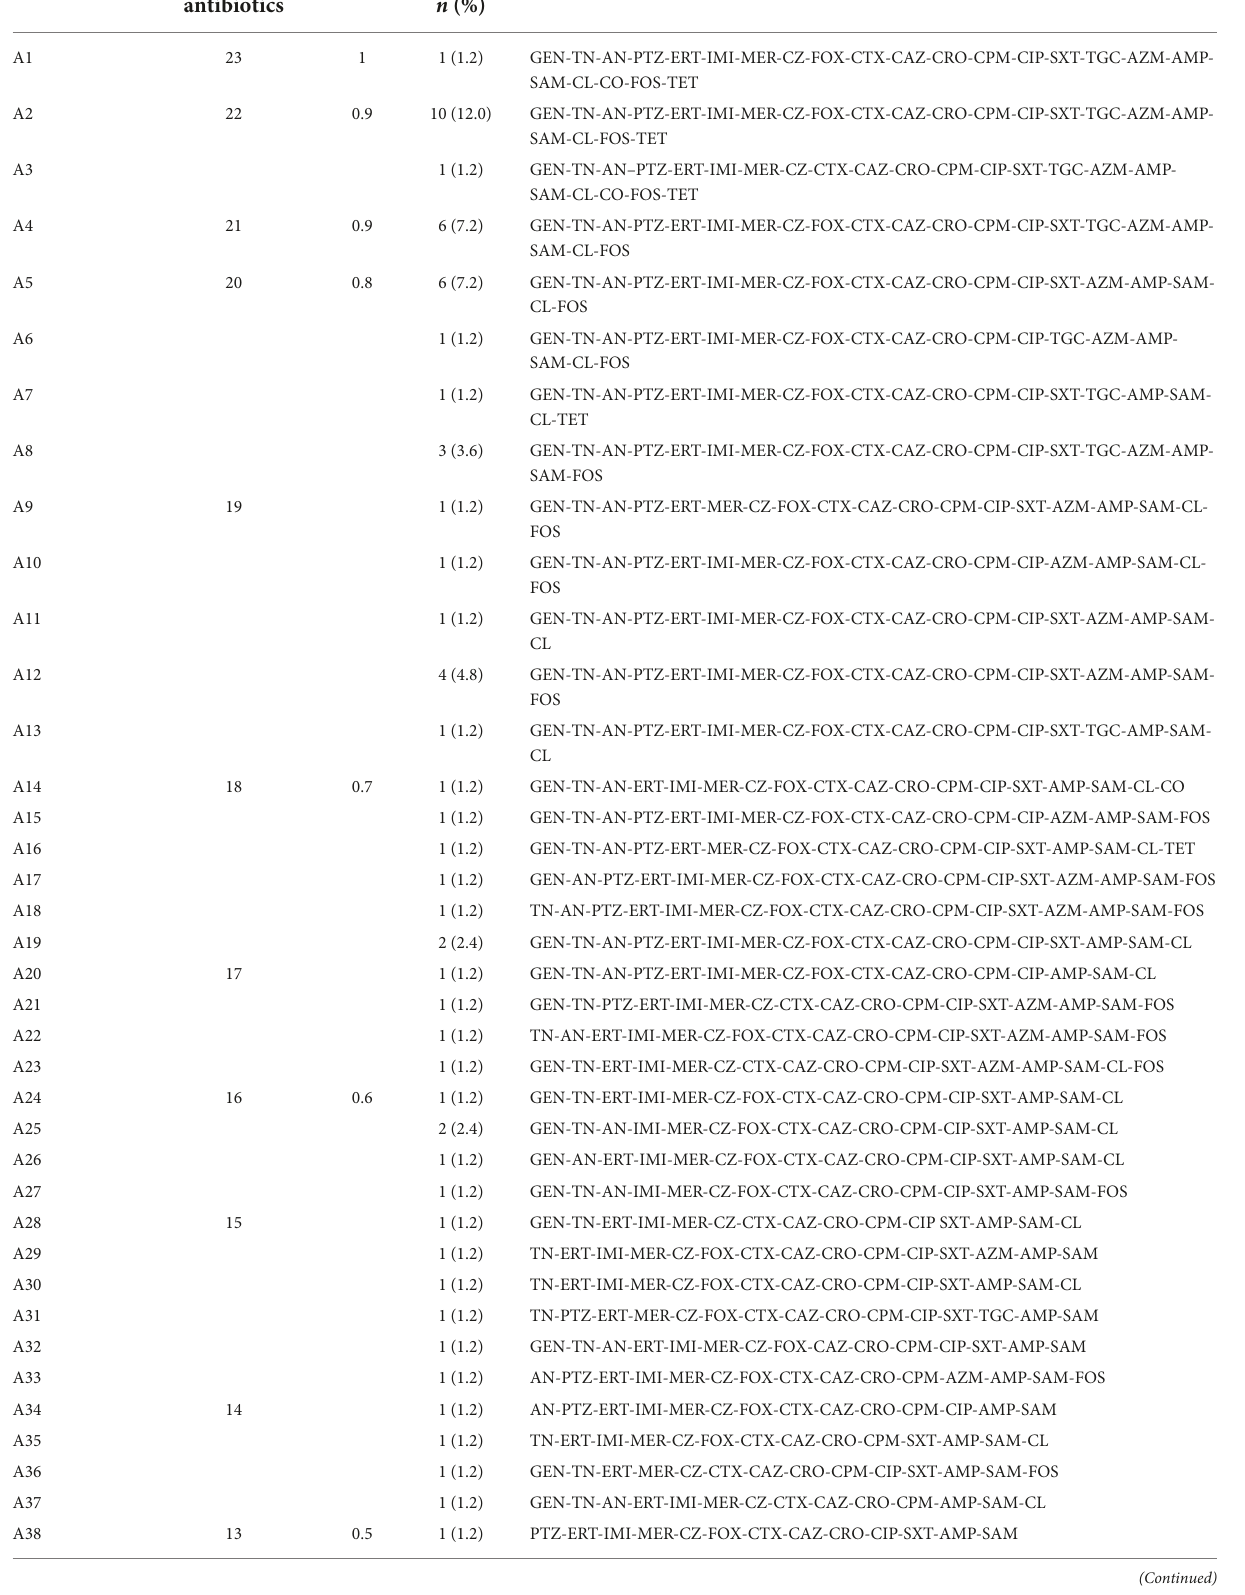
TABLE 3 Antibiotypes (antibiotic resistance patterns) of 83 carbapenem-resistant Klebsiella pneumoniae isolates.